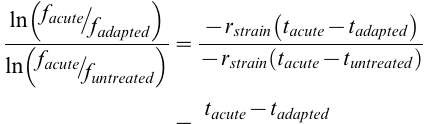
Figure S1 Growth of wild type following three different treatment protocols. Following treatment with either the acute, adapted, or untreated protocols, wild type cultures are diluted 10-fold in YPD. Recovery is monitored with a 96-well OD 600 plate reader. Each line represents the average of 12 replicates. Figure S2 RT-PCR profiling of OLE1 and FAS1 following H 2 O 2 treatment. mRNA levels of both FAS1 and OLE1 are profiled 60 minutes following treatment with either 0.10 mM or 0.15 mM H 2 O 2 . Levels are normalized to ACT1 and reported as a log ratio relative to untreated. Figure S3 RT-PCR profiling of FAS1 mRNA levels at different time points. The level of FAS1 mRNA is profiled at 30 and 60 minutes following treatment with 0.15 mM H 2 O 2 with RT- PCR. mRNA levels are normalized relative to ACT1 and reported as a log 2 ratio relative to an untreated sample. Reported p-values are determined with a one-sample t-test testing the difference from a true mean of zero. Figure S4 Growth of yap1 D following three different treatment protocols (adapted, acute, untreated). Following treatment with either the acute, adapted, or untreated protocols, yap1 D cultures are diluted 10-fold in YPD. Recovery is monitored with a 96-well OD 600 plate reader. Each line represents the average of 12 replicates. Figure S5 Growth of mga2 D following three different treatment protocols (adapted, acute, untreated). Following treatment with either the acute, adapted, or untreated protocols, mga2 D cultures are diluted 10-fold in YPD. Recovery is monitored with a 96-well OD 600 plate reader. Each line represents the average of 12